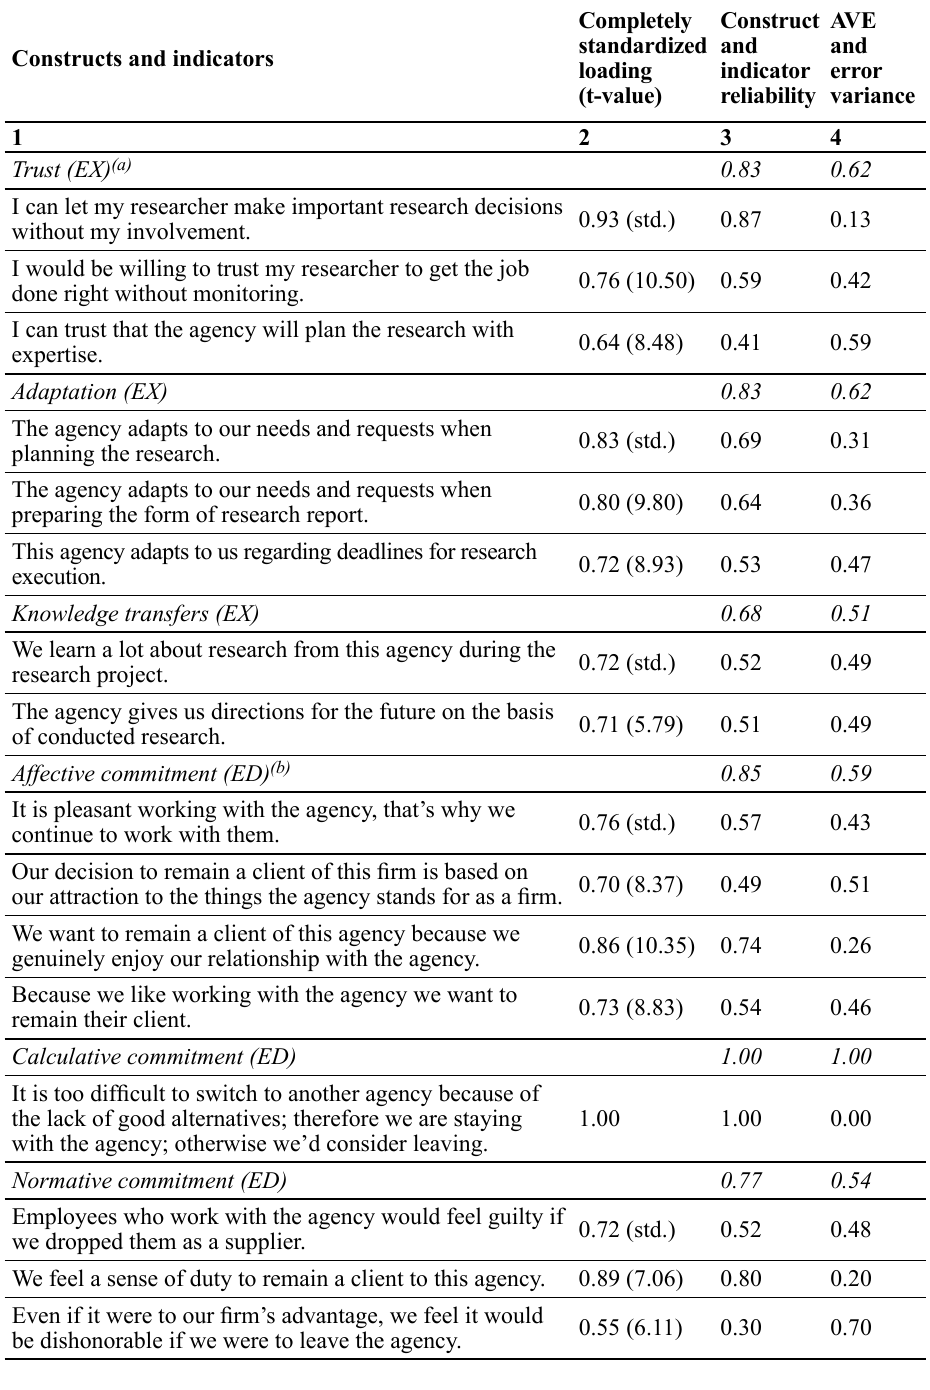
Table 3. Overall CFA for the modified measurement model based on the IMP approach (n = 150)